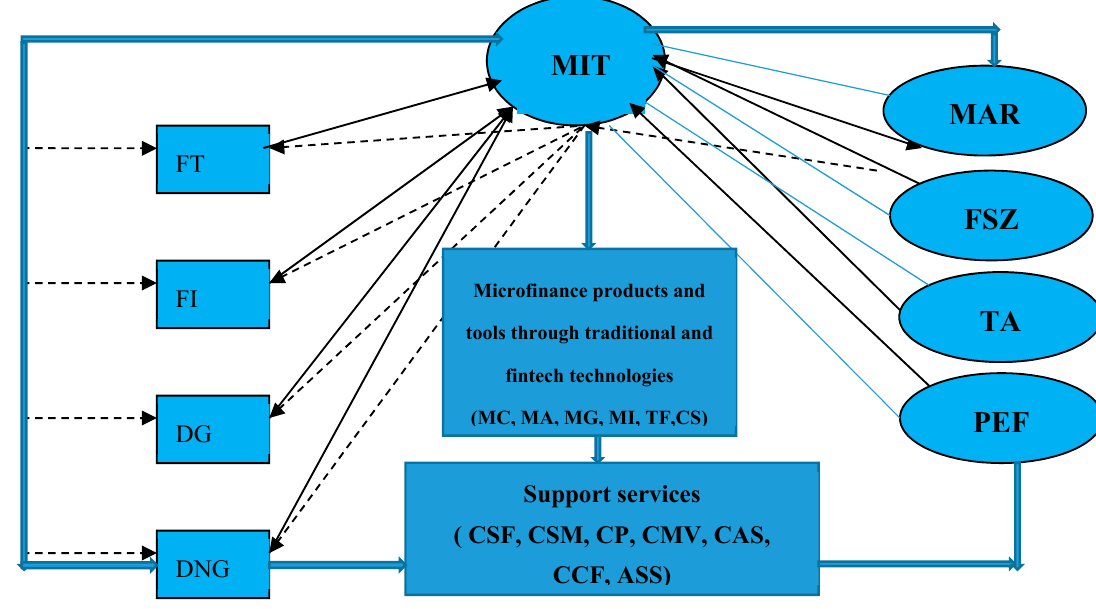
Figure 3. The microfinance entrepreneur model .